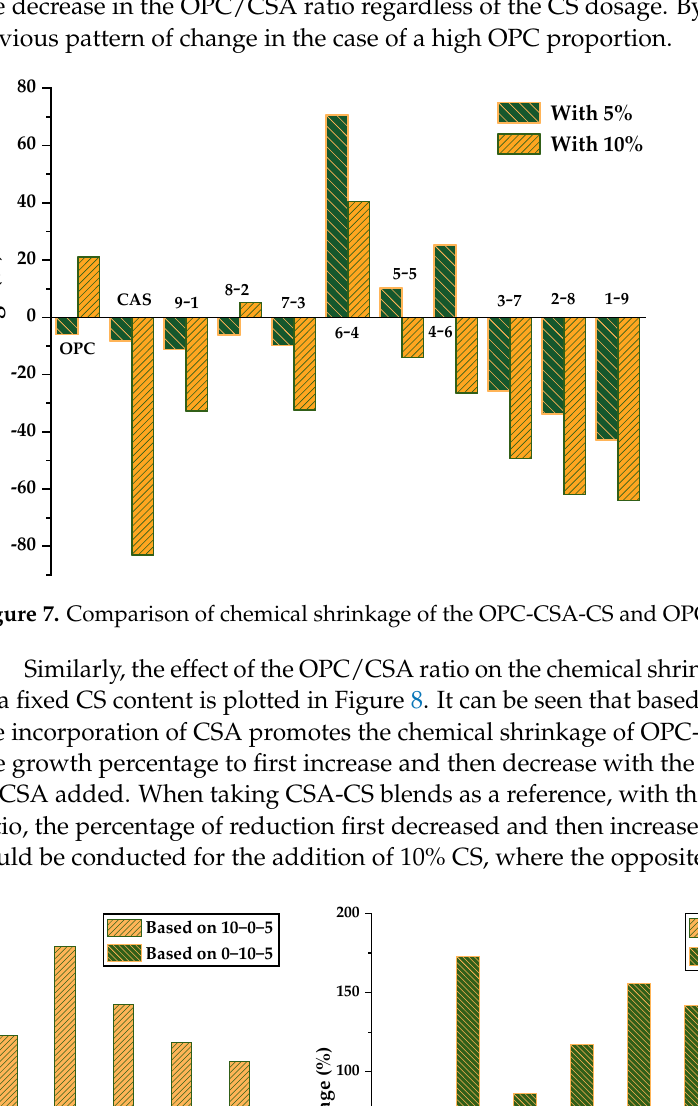
Figure 6. Chemical shrinkage of OPC-CSA-CS ternary systems: ( a ) with 5% CS; ( b ) with 10% CS. To better evaluate the influence of the addition of CS on the chemical shrinkage, the percentage was calculated by the difference between ternary blends and binary systems